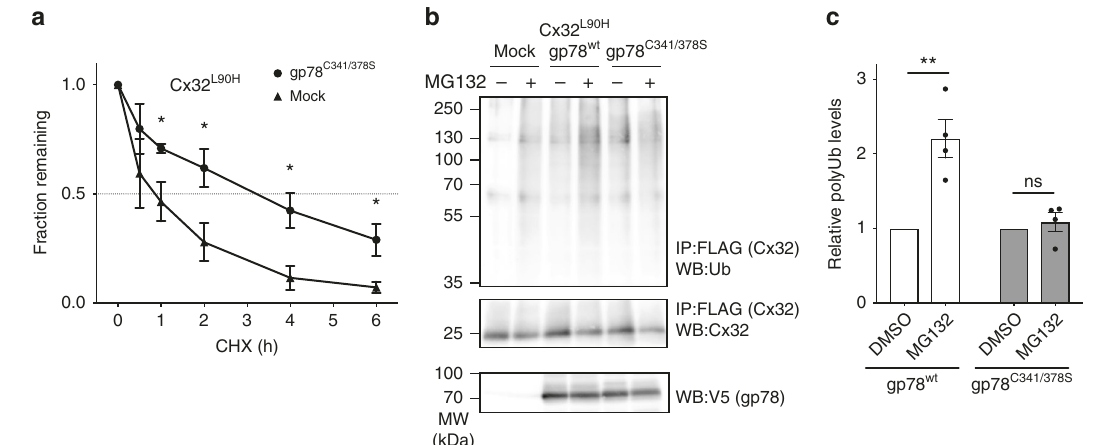
Fig. 4 gp78 mediates Cx32 degradation. a Overexpression of a nonfunctional gp78 mutant (C341/378S) signi fi cantly decelerates Cx32 L90H degradation (mean ± SEM, N ≥ 3, * P value < 0.05, two-tailed Student ’ s t tests). b Mutant gp78 (C341/378S) overexpression inhibits polyubiquitination of Cx32. FLAG- tagged Cx32 L90H was expressed either alone or in the presence of V5-tagged wild type gp78 or gp78 C341/378S as indicated. Samples were immunoprecipitated against FLAG (Cx32 L90H ) and blotted against Cx32 or ubiquitin (Ub). Where shown, MG132 was added to inhibit proteasomal degradation of Ub-modi fi ed Cx32 L90H . As can be seen from the blots and quanti fi cations in c , MG132 leads to increased ubiquitination of Cx32 L90H in the absence or presence of gp78 wt overexpression, while gp78 C341/378S overexpression inhibits Cx32 L90H polyubiquitination. c Quanti fi cations of the data shown in b (mean ± SEM, N = 4, ns: nonsigni fi cant, ** P value < 0.01, two-tailed Student ’ s t